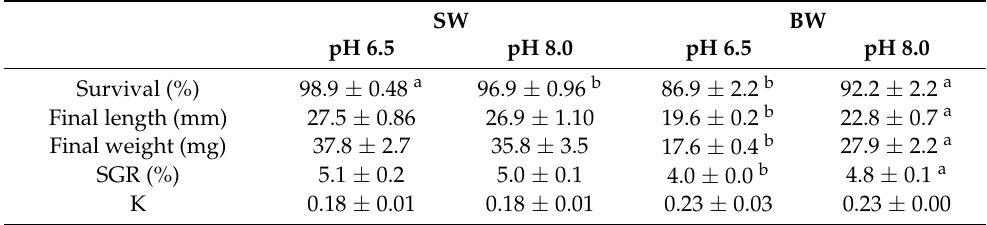
Table 3. Trial 1—Effects of pH and salinity on survival, growth, specific growth rate (SGR) and condi- tion factor (K) (mean ± standard deviation) in H. reidi juveniles reared in seawater (SW—salinity 33) or brackish water (BW—salinity 11) at pH 6.5 or 8.0 for 21 days (age 0–21 DAR—days after the male’s pouch release).